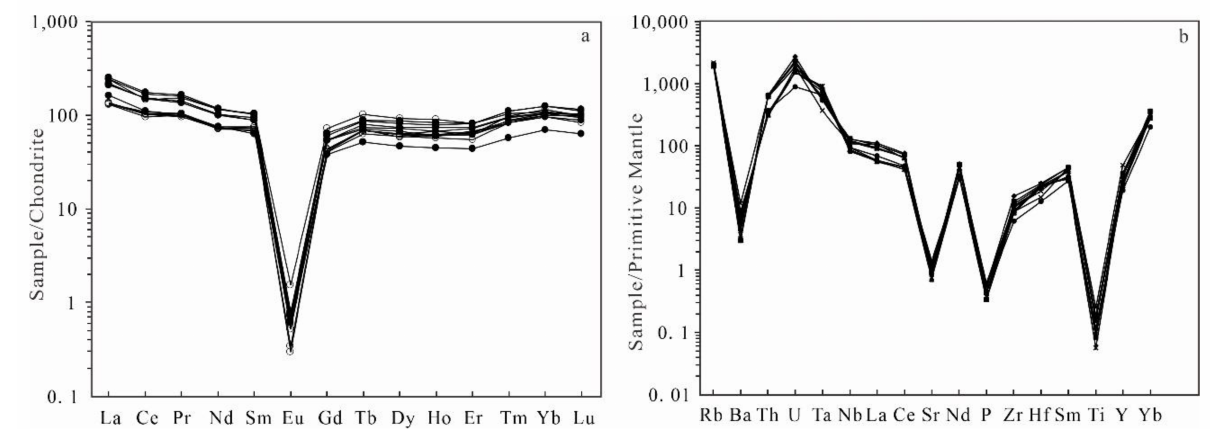
Figure 7. Chondrite-normalized REE pattern ( a ) and primitive mantle-normalized multi-element diagram ( b ) for the